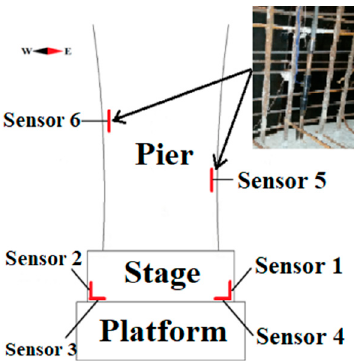
Figure 7. Schematic diagram of the arrangement of reinforced stress gauges in concrete piers.